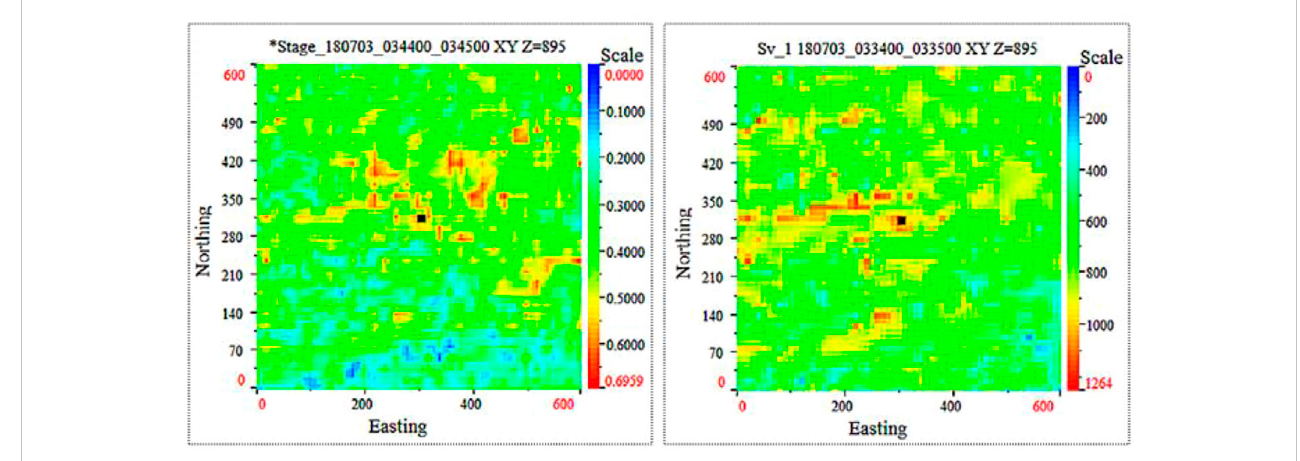
FIGURE 6 Instantaneous and cumulative fracture energy diagram at the 26th minute.